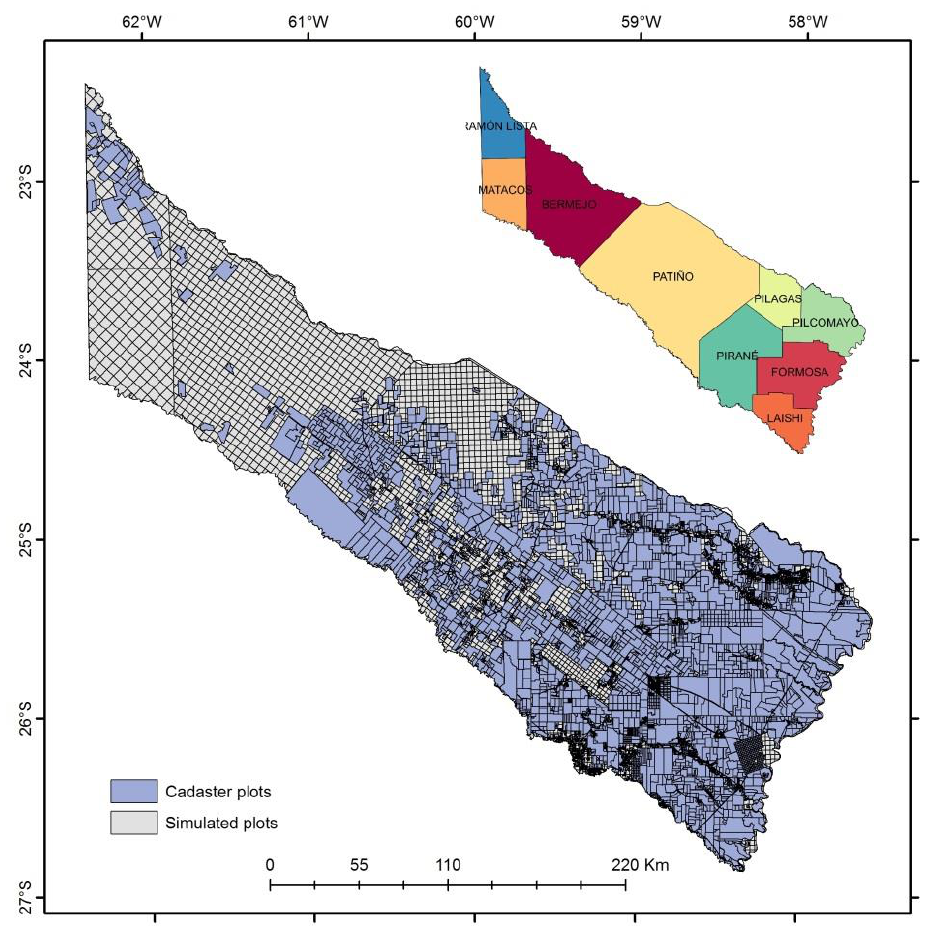
Figure A1.2. Cadaster map with actual and simulated plots used as base for the spatial simulations. Upper right: Administrative division of the province in